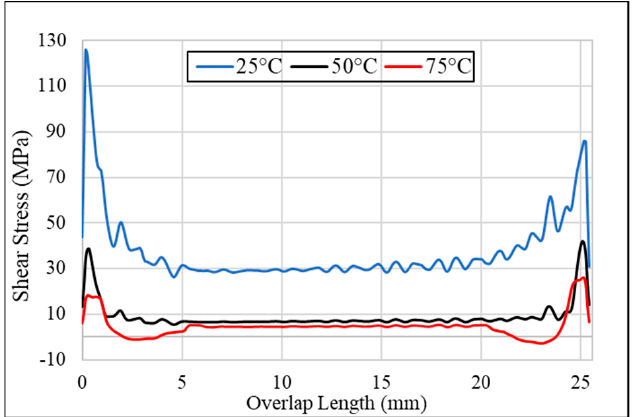
Figure 11. Shear stress distribution at location B of SLJ with neat adhesive at different temperatures.